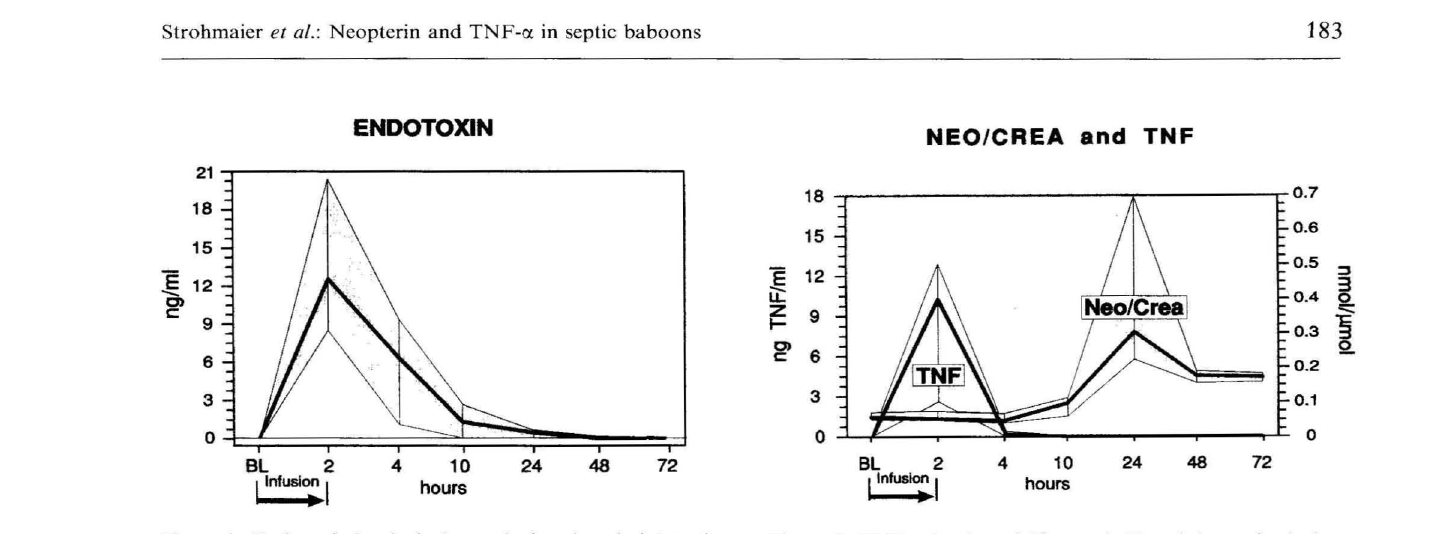
Figure 1. Endotoxin levels during and after the administration of 5 x 10 8 CFU/kg live E. coli. Solid line represents the median. the shaded area borders the 25% and 75% percentiles. (BL baseline)